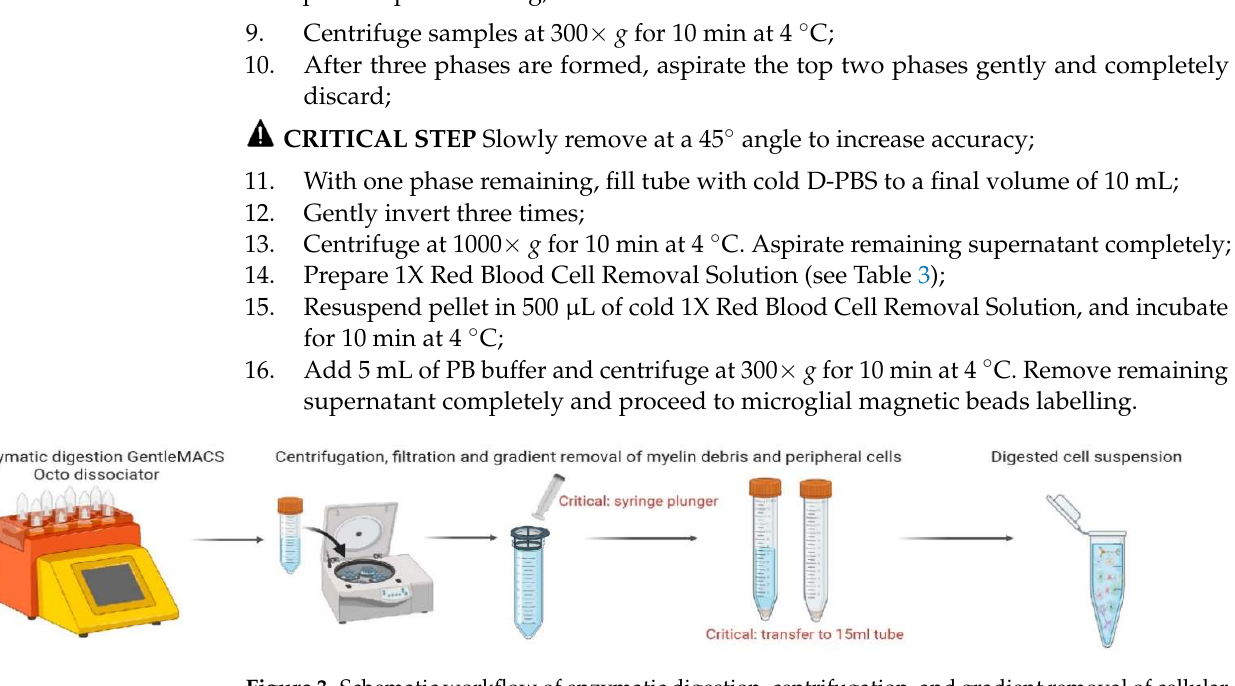
Figure 3. Schematic workflow of enzymatic digestion, centrifugation, and gradient removal of cellular debris. Critical modifications to protocol, highlighted in red, to allow for processing of small amounts of dissected brain tissue <50 mg.